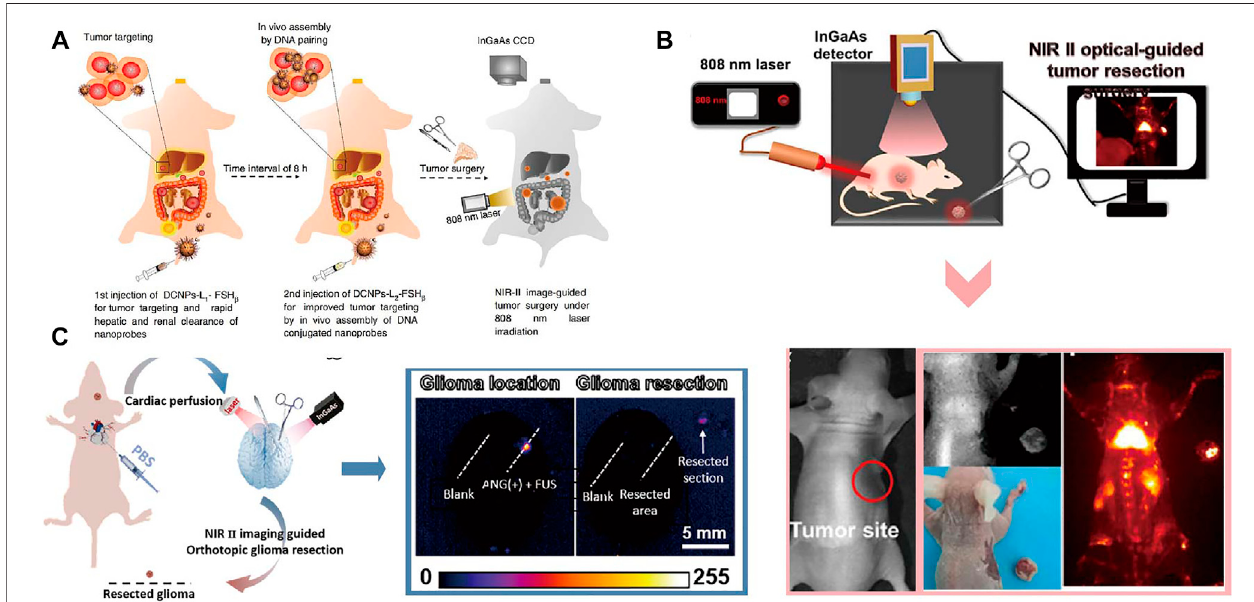
FIGURE 8 | Imaging-guided Surgery. (A) Schematic illustration of NIR-II optical imaging-guided surgery of ovarian metastasis (Wang et al., 2018a). Reproduced with permission from Zhang et al. (2018). (B) The NIR-II bioimaging guided tumor resection of the colorectal tumor-bearing mouse (Li et al., 2020b). Reproduced with permission from Zeng et al. (2020). (C) Schematic illustration of NIR- II fl uorescence imaging guided resection of orthotopic glioma (Ren et al., 2020). Reproduced with permission from Li et al.